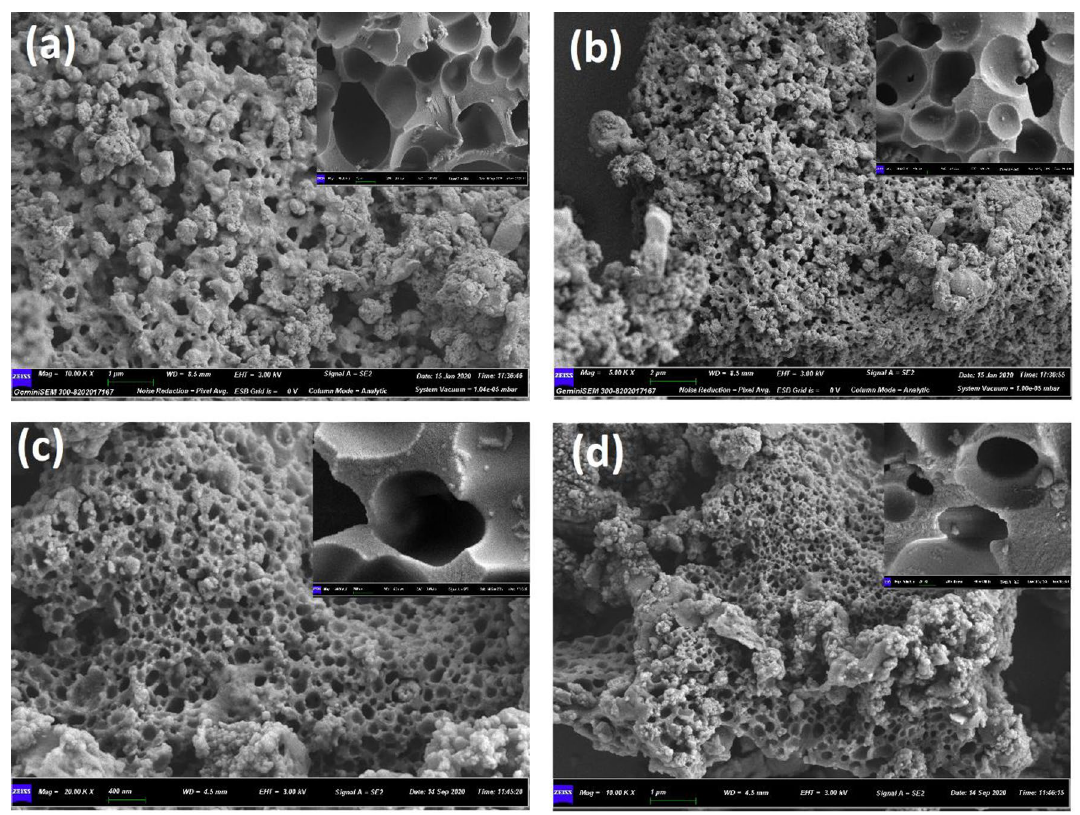
Fig. 2 SEM micrographs and partial enlarged photographs of BODIPY-based polymers a PY1, b PY2, c PY3, and d